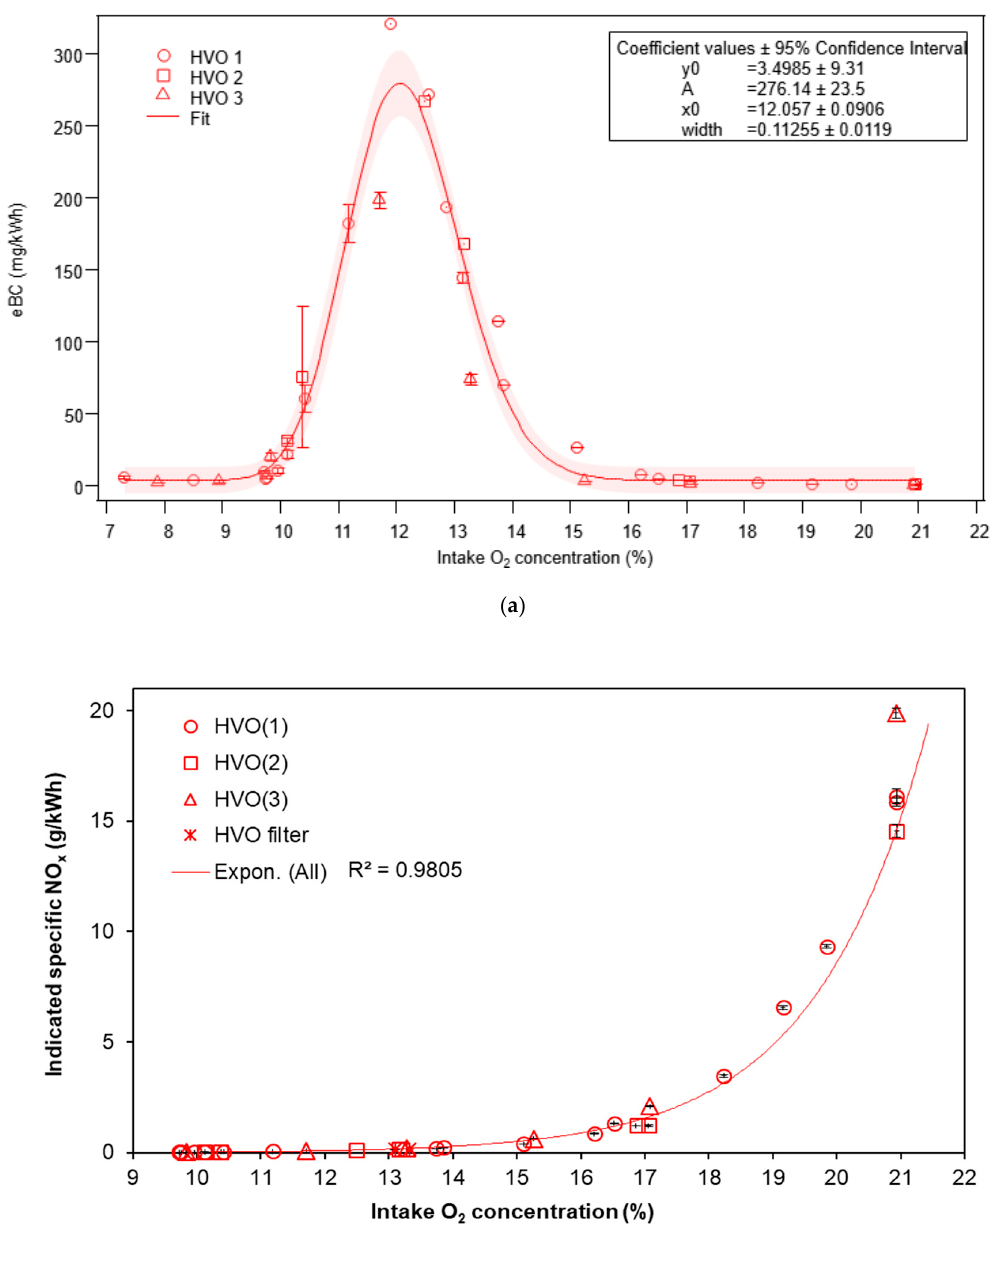
Figure A3. The ( a ) eBC emissions (g/kWh) and b) NO x (g/kWh) of EGR sweeps on three different days (i.e., repeated experiments) of HVO depending on EGR (expressed as intake O 2 concentration). Error bars represent the measurement variabilities (±1 std. dev.) for the sampling periods. A ( a ) lognormal function and ( b ) exponential function was fit to all data points. Consideration of measurement uncertainties (±1 std. dev.) was included in the fitting procedure. The shaded area in ( a ) represents the 95% confidence interval of the fit, and can be regarded as a constraint on the uncertainty.